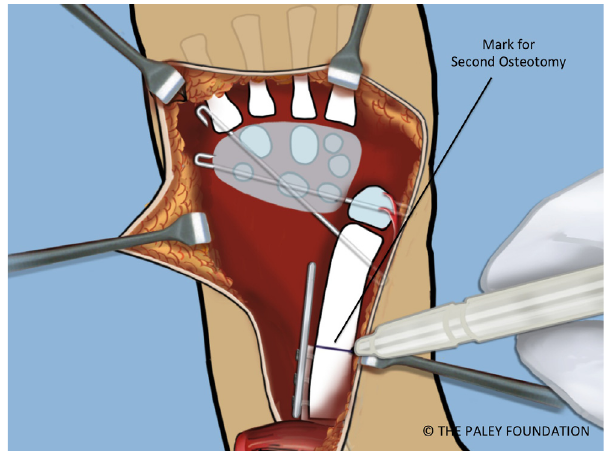
Figure 19. With the bone ends overlapped and the wrist pinned, the level of the shortening osteotomy should be marked.